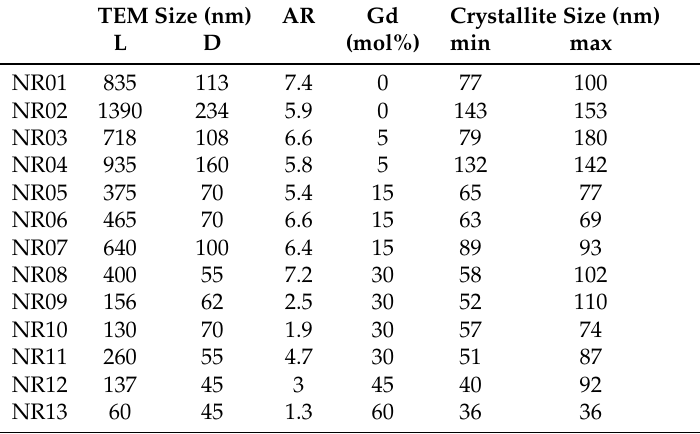
Table 5. Main parameters of the studied NPs (with L for Length, D for Diameter, AR for Aspect Ratio) and the apparent size obtained by the anisotropic model. Here only the nominal gadolinium concentration is